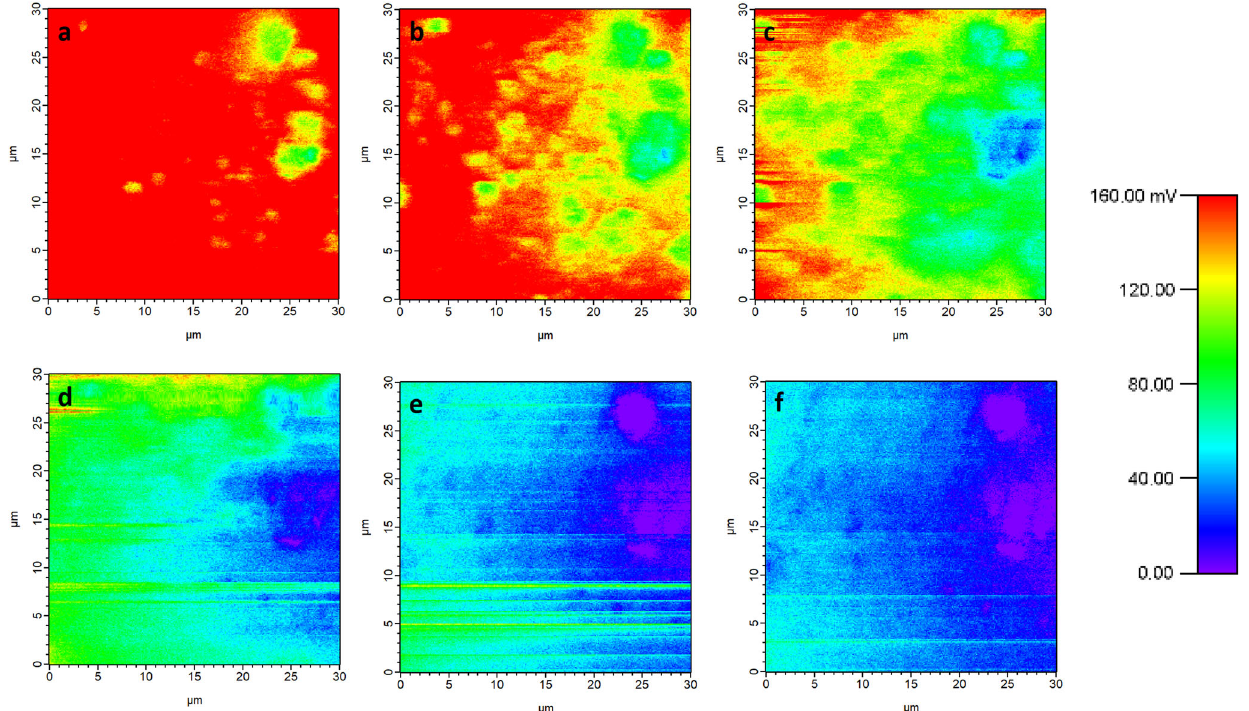
Fig. 7 High-resolution electrode potential mappings obtained during in situ cation migration on the surface of the sample 10C-1.5O at different times. a 0 min ( fi rst scan after placing the electrolyte droplet), b 8 min, c 16 min, d 24 min, e 48 min, and f 80